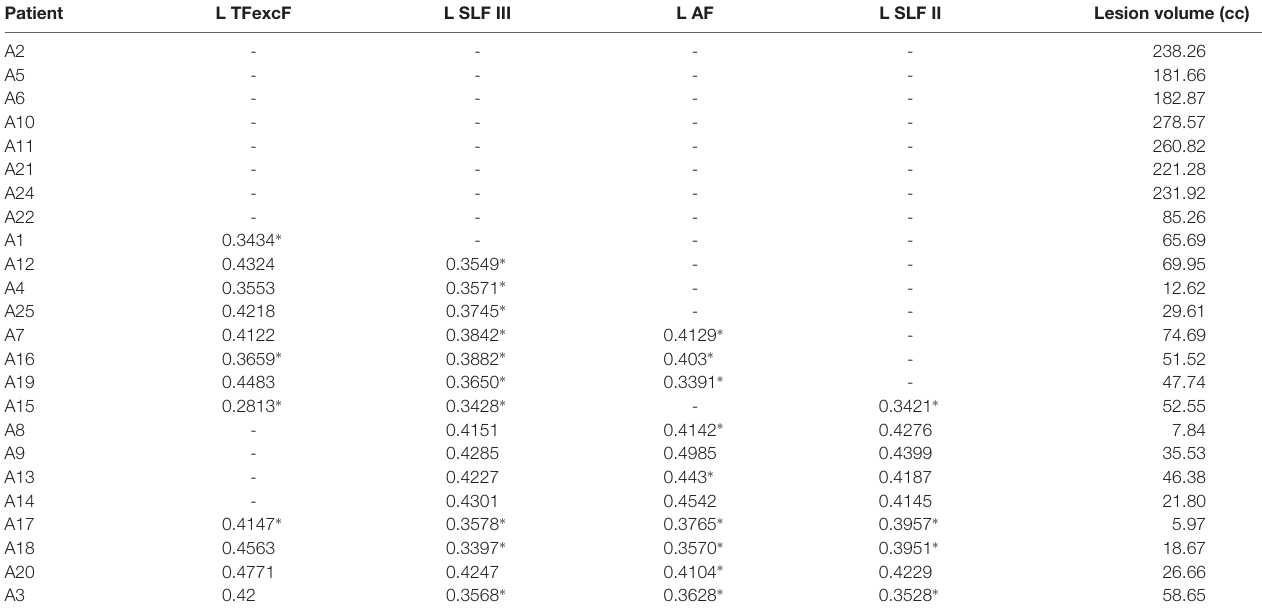
TABLE 2 | Lesion volume in cubic centimeters and FA values calculated for the left hemisphere TFexcF, SLF III, AF, and SLF II of the patients with aphasia. Patient